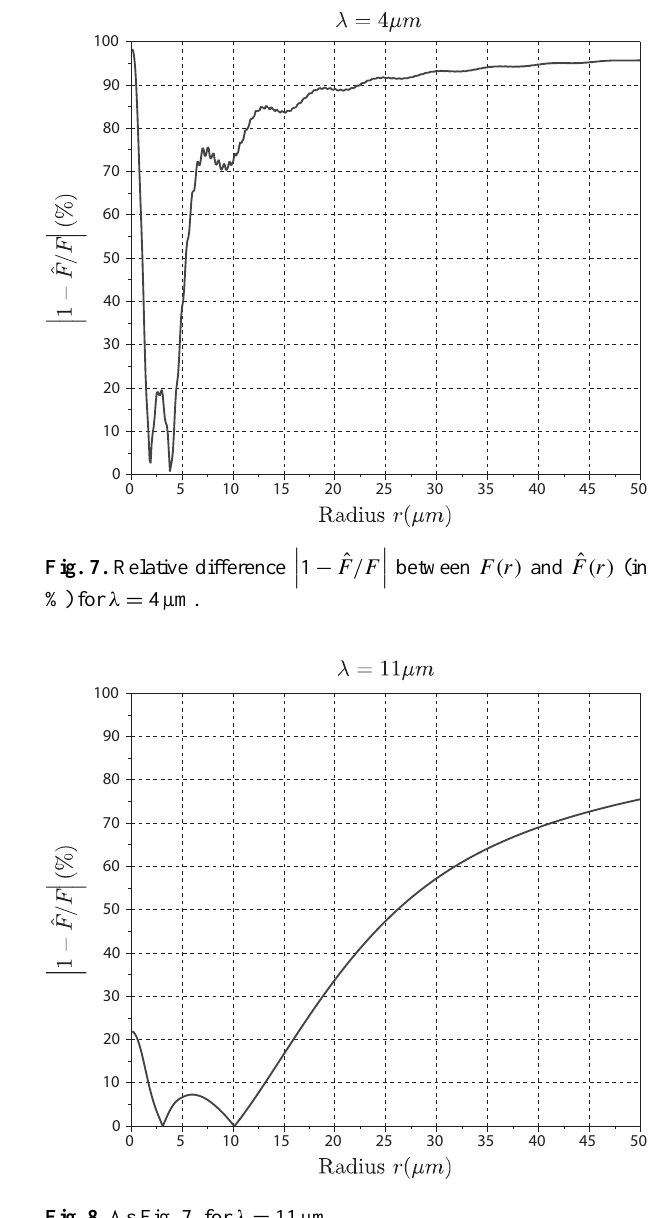
Fig. 8. As Fig. 7, for λ =